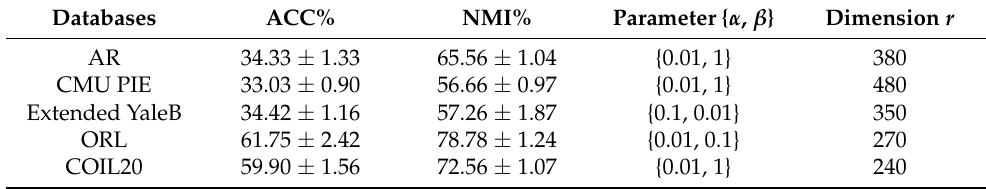
Figure 7. The clustering accuracy (ACC) of different parameter values: ( a ) parameter α ; ( b ) parameter β . Table 8. The optimal combination of parameters and dimension on the clustering task.